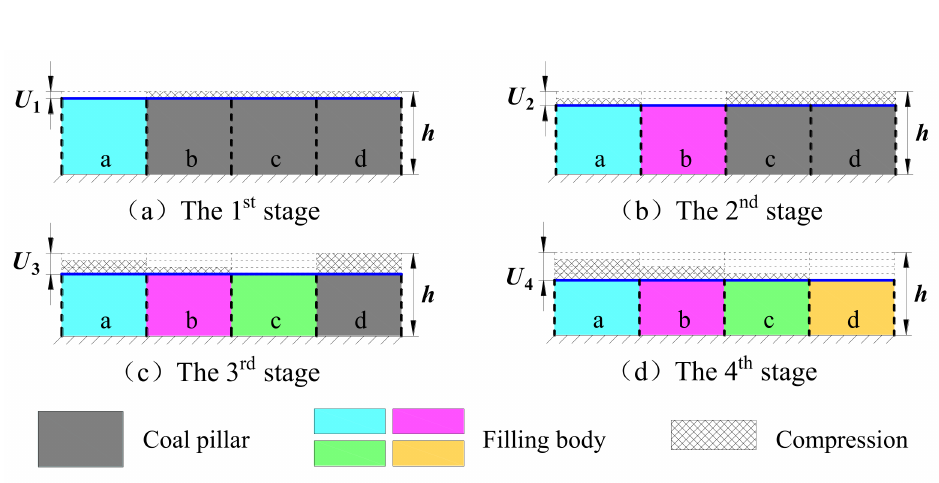
Figure 7. The compression amount of coal pillars and filling bodies in every stage. ( a ) The 1st stage; ( b ) The 2nd stage; ( c ) The 3rd stage; ( d ) The 4th